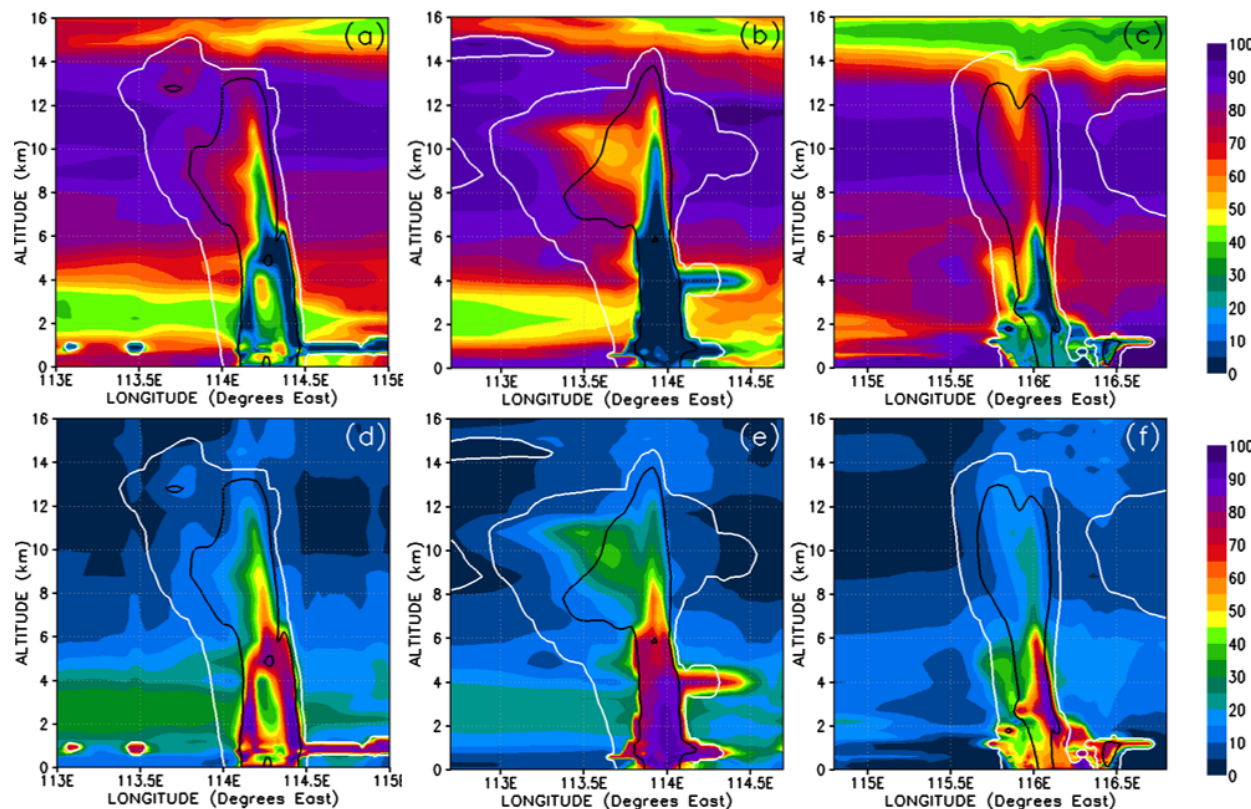
Figure 14. Vertical cross sections similar to Fig. 13 but for the percentage contributions of HBr (a–c) and HOBr (d–f) to the total inorganic Br mixing